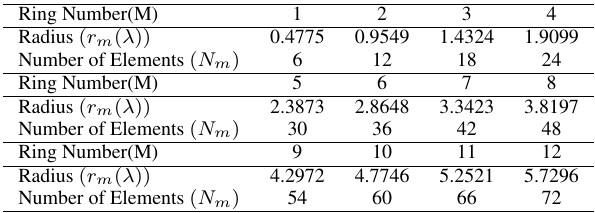
TABLE 1: Ring radius and number of elements per ring Ring Number(M)